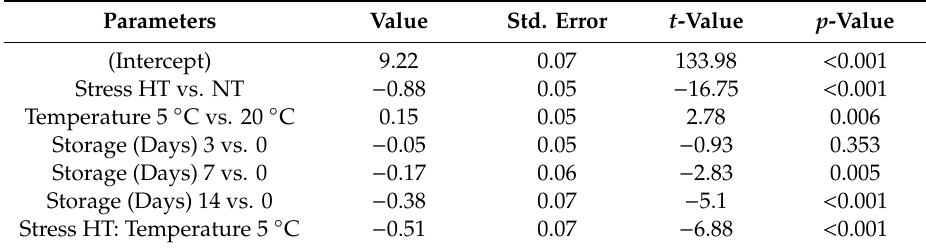
Table 2. Predictive factors for the number of bacteria identified by the Linear Mixed Effects Model. Parameters